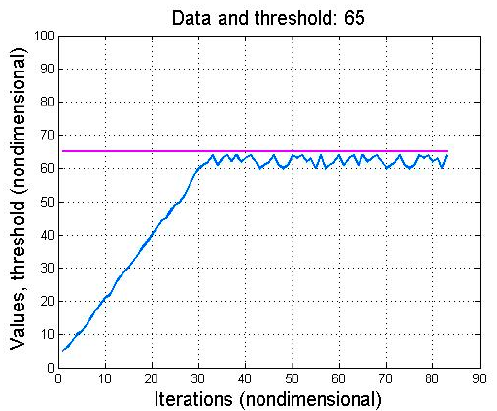
Figure 7. Threshold (65) and dataset (in its vicinity).